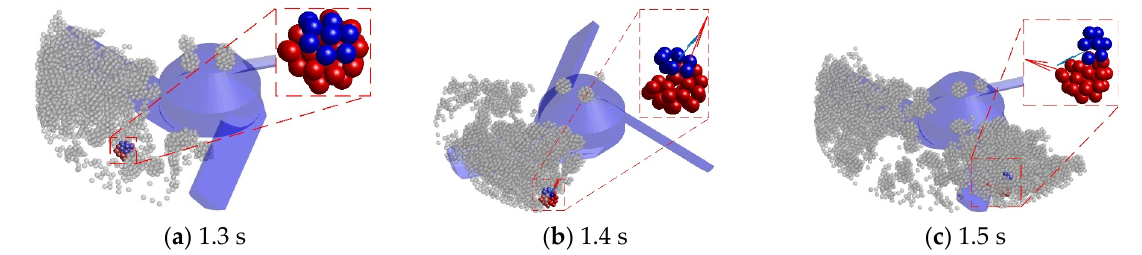
Figure 7. Compression breaking by the impeller.